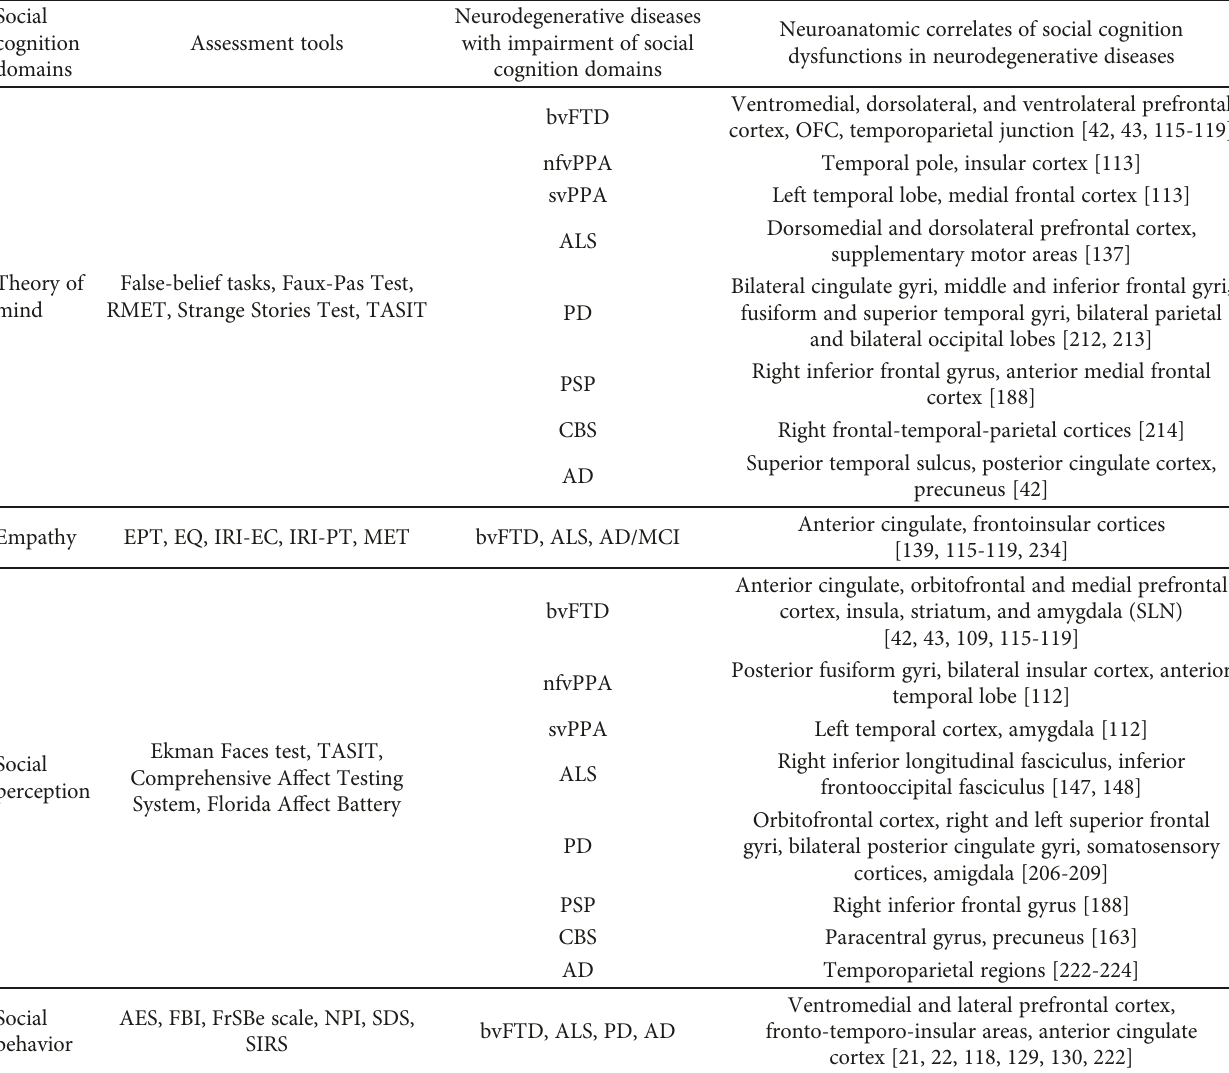
Table 1: Social cognition domains with the related assessment tools for clinical and research investigation of social cognition de fi cits in neurodegenerative